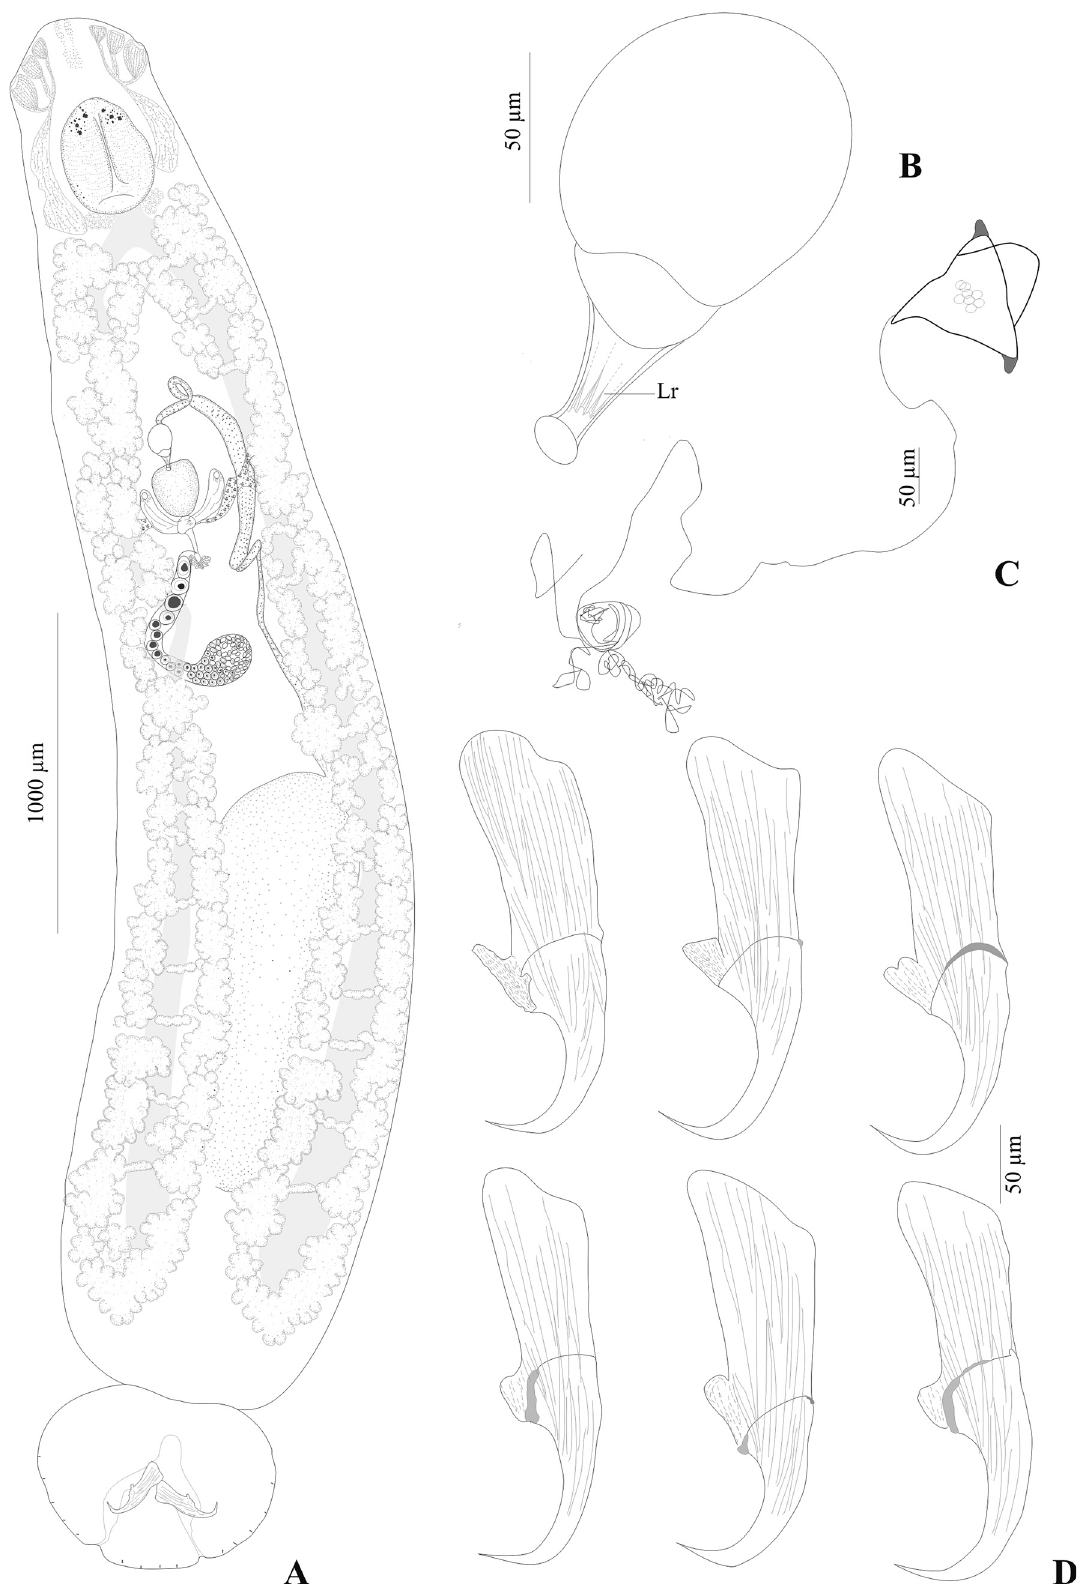
Figure 2. Triloculotrema euzeti n. sp. from Mustelus punctulatus . (A) Whole-mount (composite, ventral view), (B) male copulatory organ, (C) egg, (D) hamuli, variations according to different specimens. Abbreviations: Lr, longitudinal